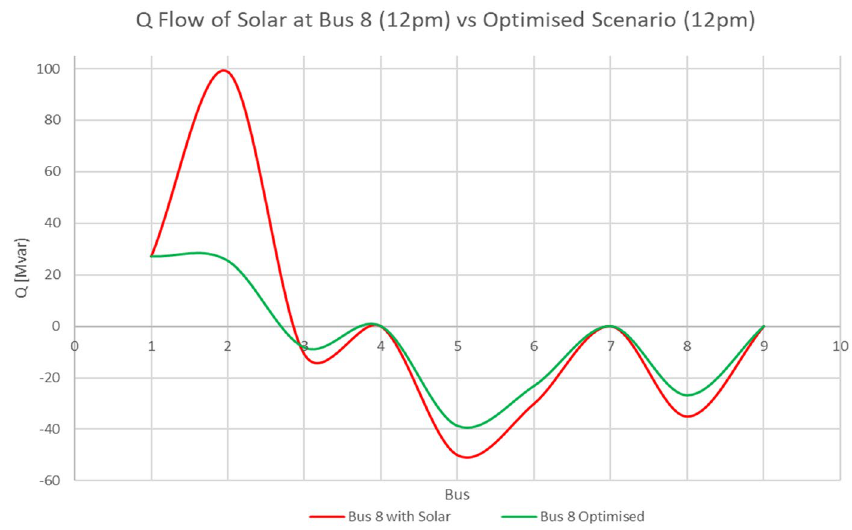
Fig. 11 Reactive power flow of 9 bus with solar at bus 8 versus the optimised